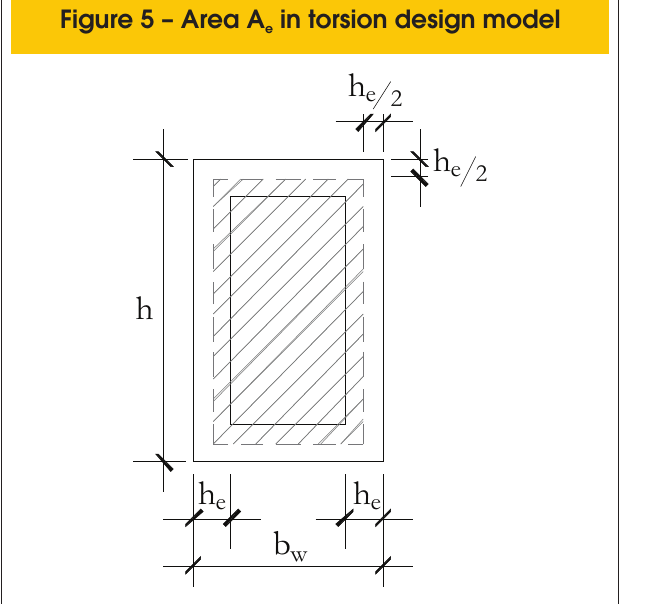
Figure � � Area A in torsion design model e